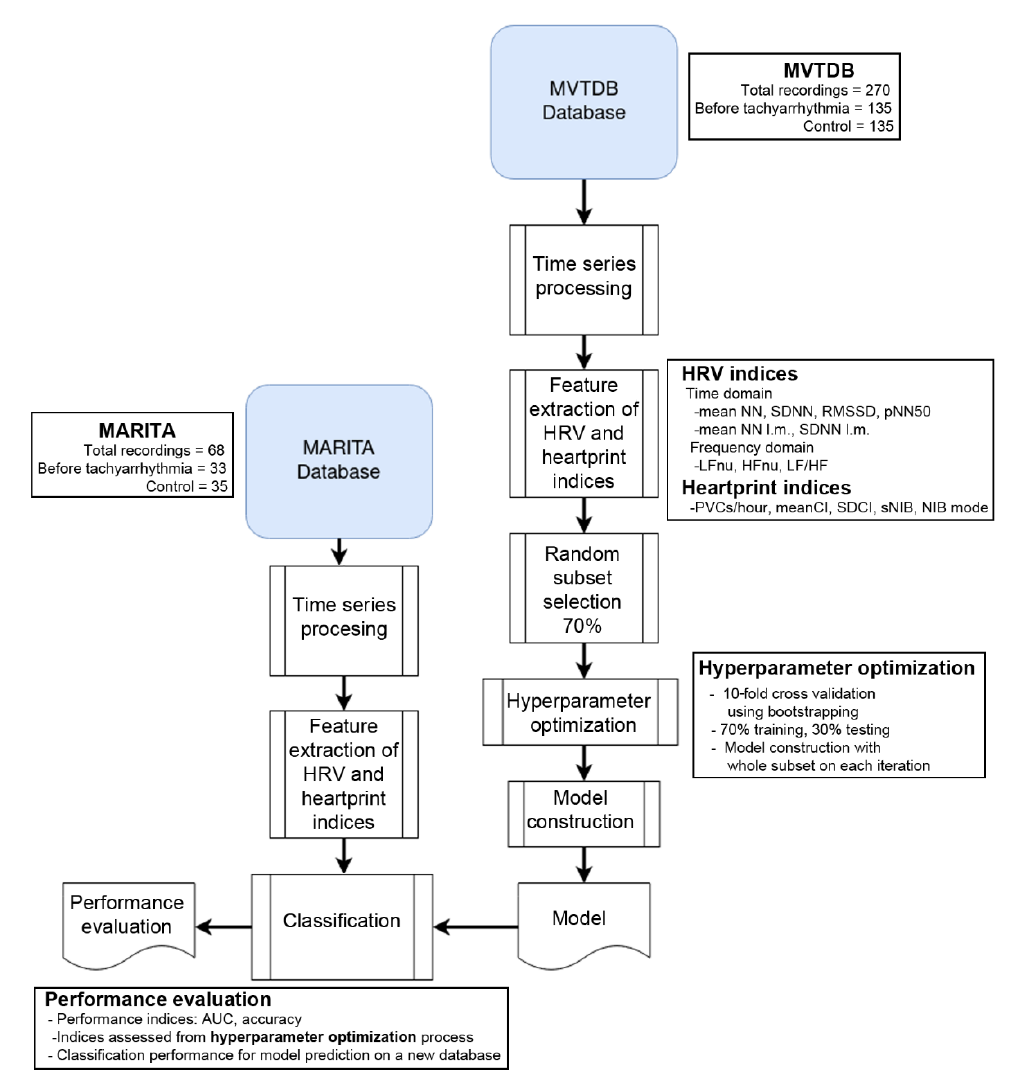
Figure 2. Flow chart of the study design: database description, a short description of the used features, structure of the classification method and performance evaluation. MARITA = MARITA study (Multivariate Analysis of RR-Intervals to predict ventricular TachyArrhythmia), MVTDB = Spontaneous Ventricular Tachyarrhythmia Database.